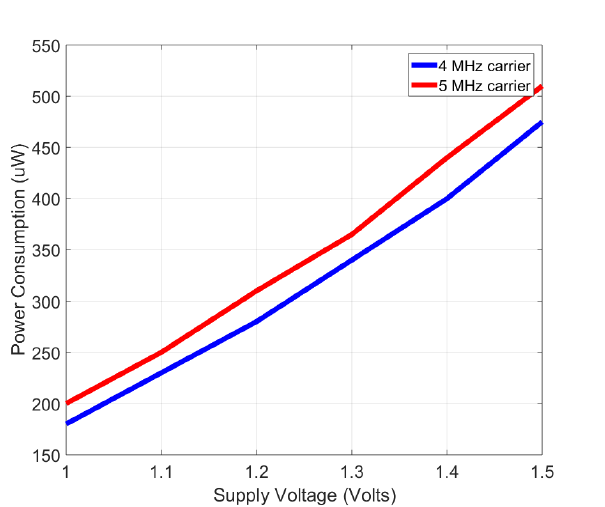
Figure 18. Measured power consumption of the receiver vs supply voltage at 1 MHz repeated data square wave